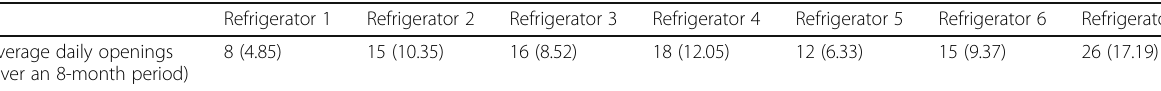
Table 2 Average daily openings of the refrigerators ’